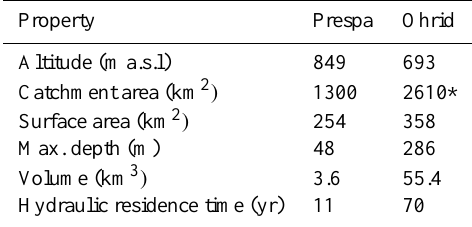
Table 1. Characteristics of Lake Prespa and Lake Ohrid (data after Matzinger et al., 2006a). Property